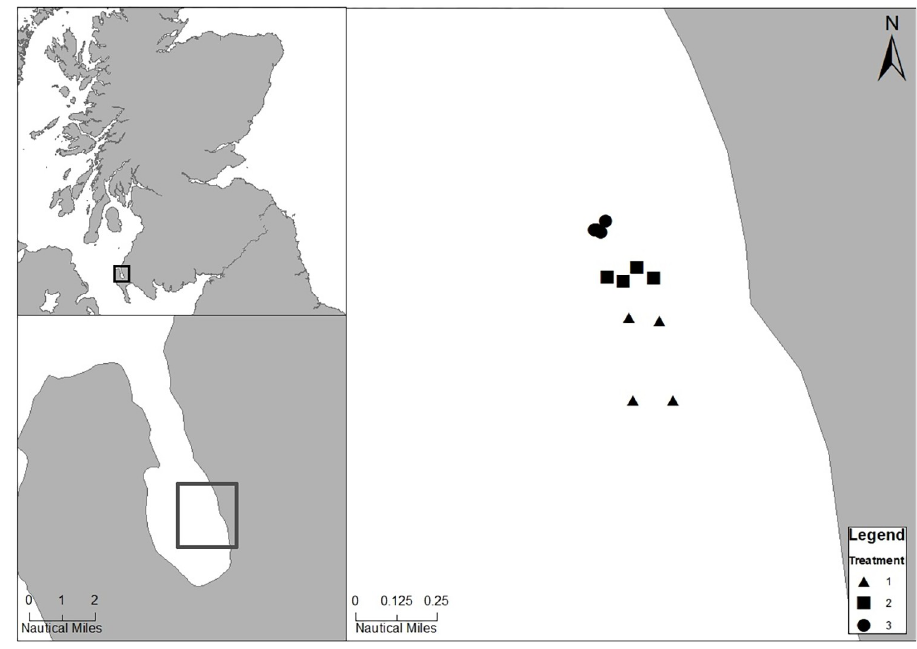
Fig 1. Loch Ryan and the location of the study site off Leffnoll Point and sample locations. (Map made using ArcGIS [Esri UK, Esri, 2022, Garmin, GeoTechnologies, Inc., USGS | Esri, 2022]).